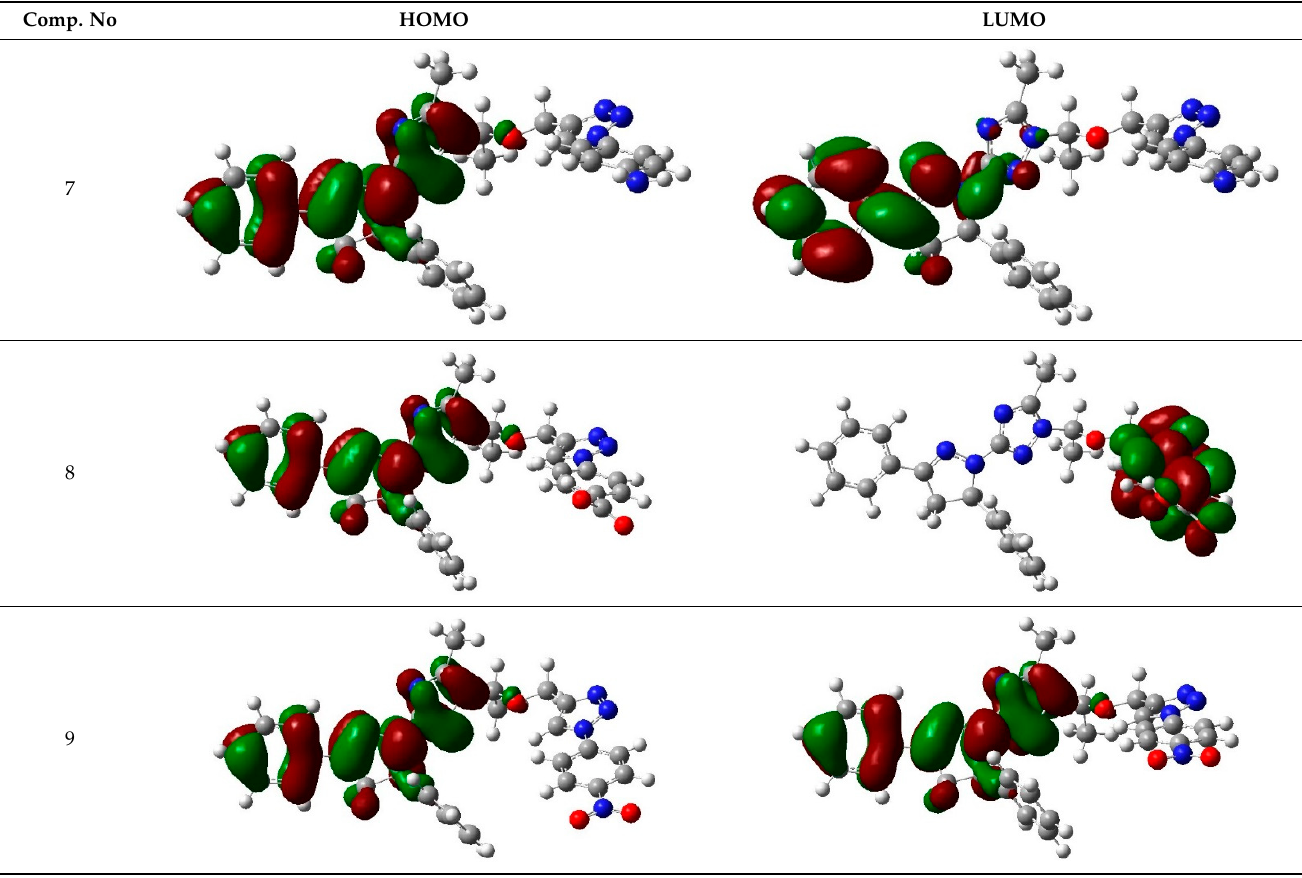
Table 2. HOMO orbital energies (E HOMO ), LUMO orbital energies (E LUMO ), energy gap (E g ), oscillator strength ( f ) calculated by the TD-DFT in gas phase and H 2 O. Comp.